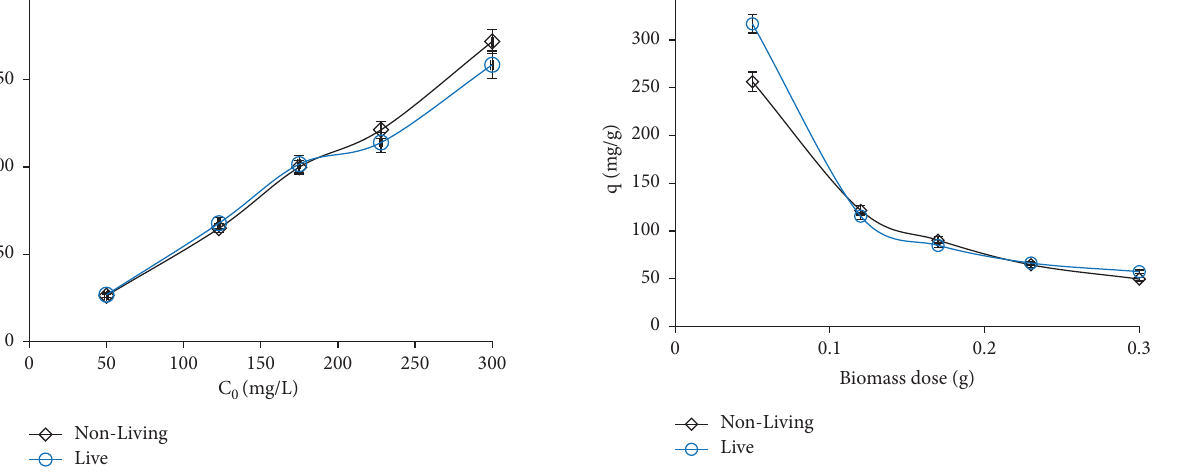
Figure 1: Efect of Pb (II) concentration on the biosorption process by Penicillium notatum (pH: 5).